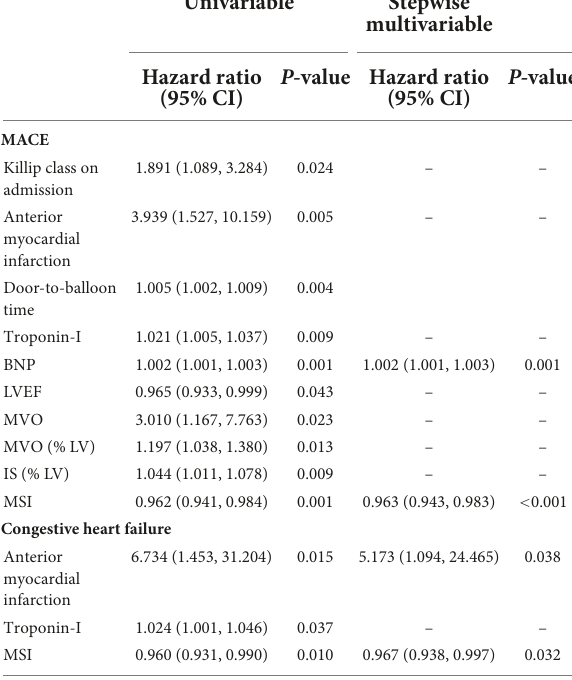
( Figure 4 ), and the best cut-off value of MSI for predicting TABLE 3 Predictors of MACE and congestive heart failure in univariable and stepwise multivariable Cox regression analysis.